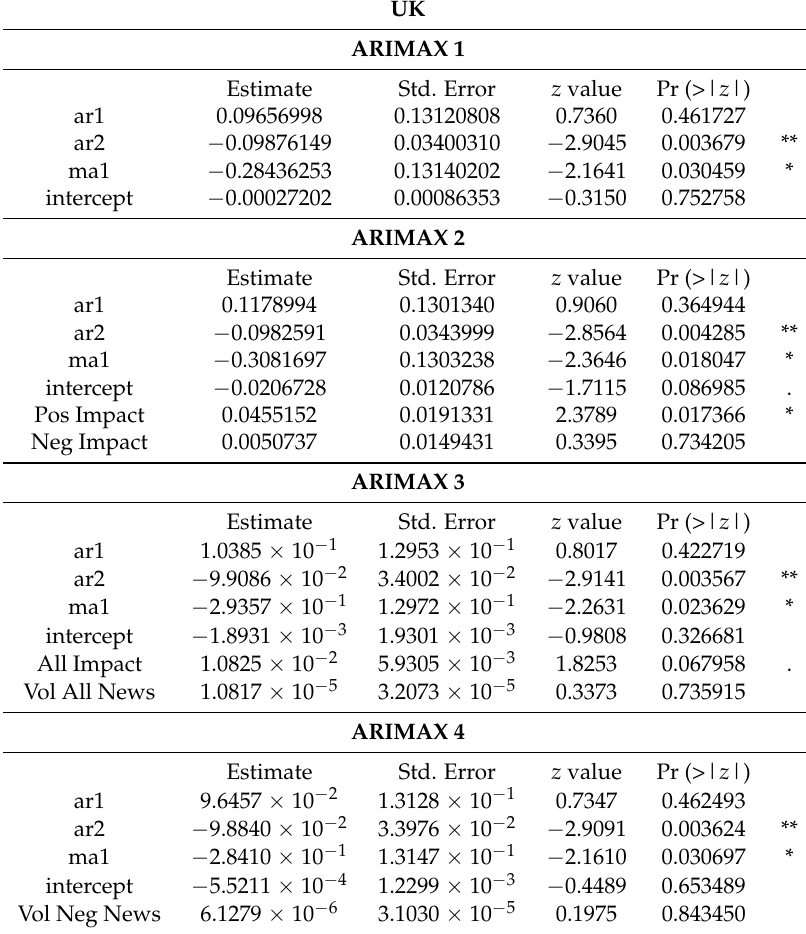
Table 19. z -test of coefficients for ARIMAX models in the UK for first difference of mean country spread. Signif. codes are: 0 ‘***’ 0.001 ‘**’ 0.01 ‘*’ 0.05 ‘.’ 0.1 ‘